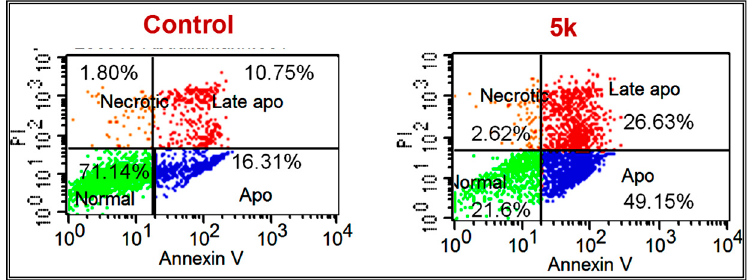
Figure 6. Fluorescein isothiocyanate (FITC)-labeled annexin V (Annexin V-FITC) staining. The cells were treated with dimethylsulfoxide (DMSO) as a control or with compound 5k at IC 50 concentration for 24 h. The experiment was done in triplicate.